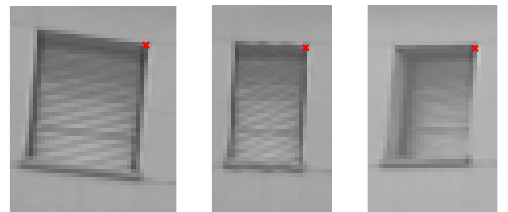
Figure 5: Feature matching: feature region in the first camera view (left), feature region mapped from the first to the second camera view (middle), feature region in the second camera view (right). The considered feature reported (red crosses) in all the